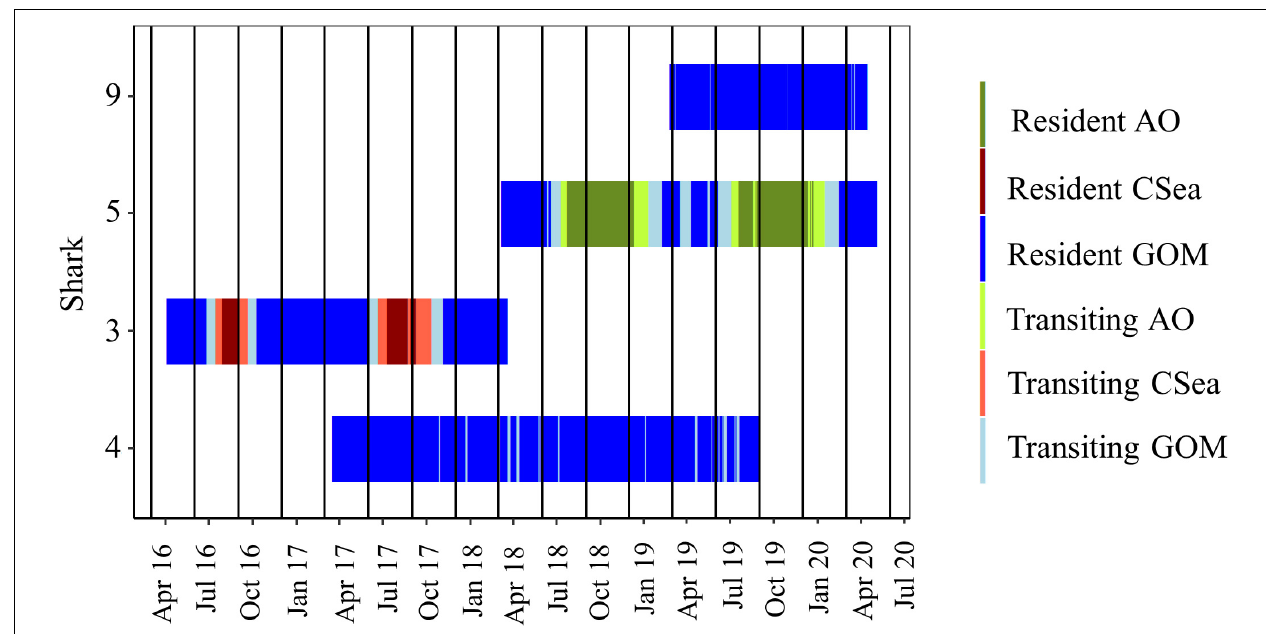
FIGURE 4 | Movement behavior of shortfin makos tracked > 100 days over the study period. Sharks demonstrated transiting behavior (light colors) and resident behavior (dark colors) based on the first-difference correlated random walk switching model. Shades of blue represents periods within the Gulf of Mexico (GOM), green represents periods within the Atlantic Ocean (AO), and red represents periods within the Caribbean Sea (CSea). Sharks 5 and 3 were mature males tracked through multiple migrations. Shark 4 was the only female tracked > 100 days. Shark 9 was the only immature male tracked > 100